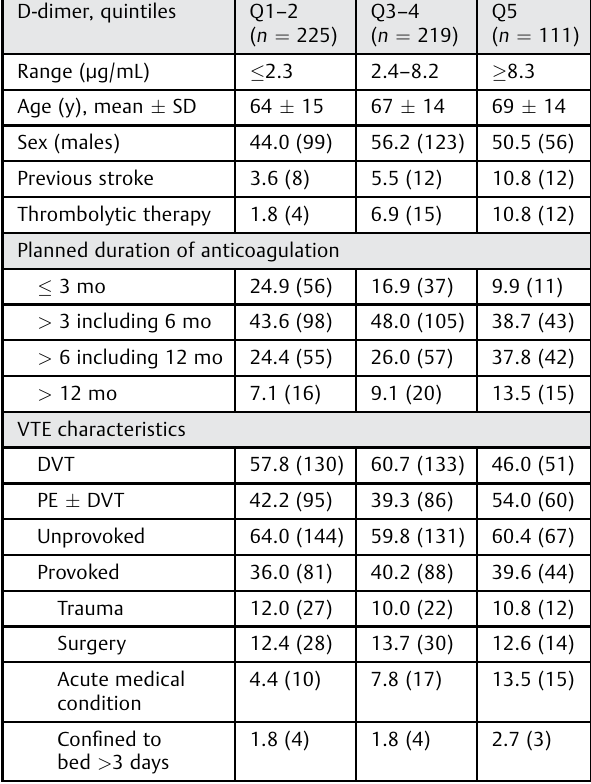
Table 1 Baseline characteristics of venous thromboembolism (VTE) cases across categories of